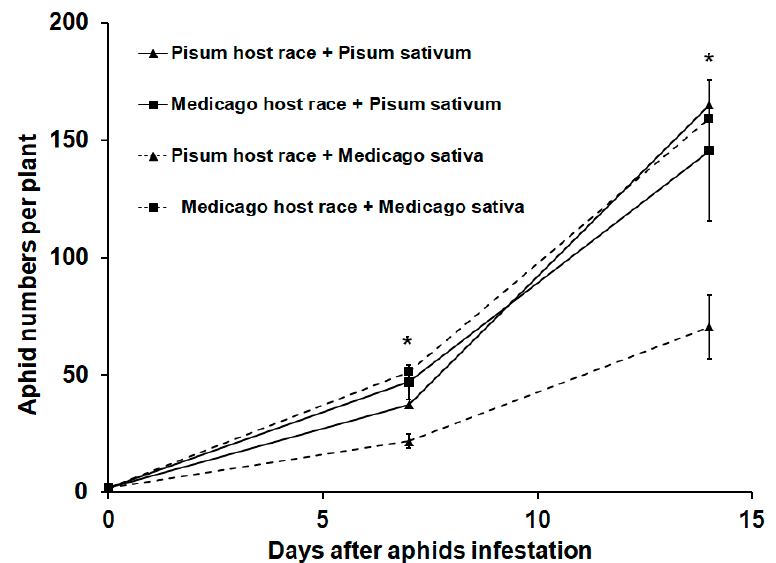
Figure 1. Population abundance of the two host races of Acyrthosiphon pisum on Pisum sativum and Medicago sativa . Each value represents the average ( ± SE) of the six replicates. “*” indicates significant differences between the Pisum host race and Medicago host race on M. sativa , as determined by Student’s t -test at p < 0.05.